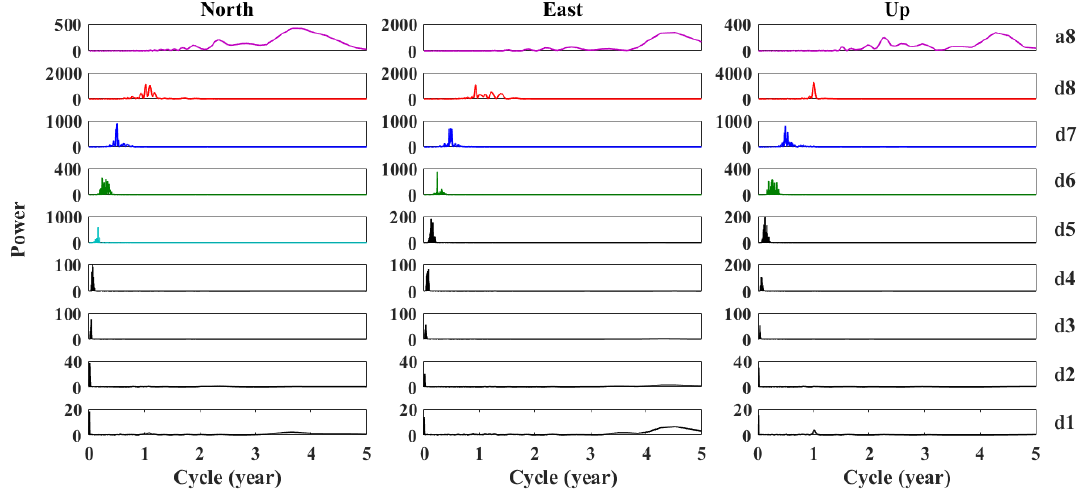
Figure 6. Reconstructed components of BJFS station using wavelet analysis.